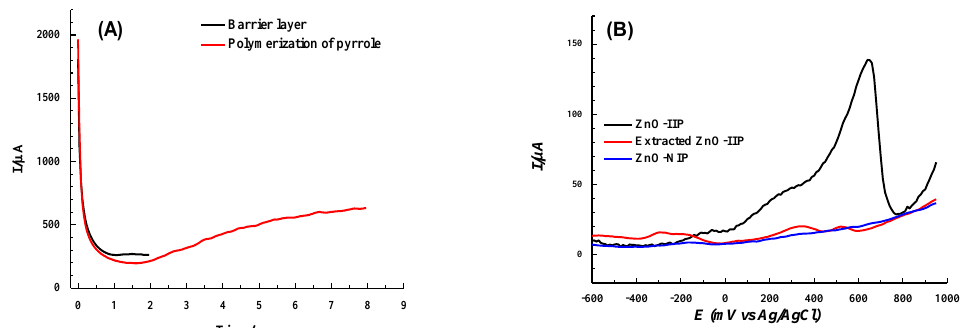
Figure 3. ( A ): Electropolymerization of pyrrole by chronoamperometry at a constant potential of 1.05 V/SSC. (black) Barrier layer, (red) Polymerization of pyrrole in the presence of L-cysteine and Hg 2+ ( B ): square wave voltammetry (SWV) of IIP and NIP in H 2 O/KCl 0.1 M solution.